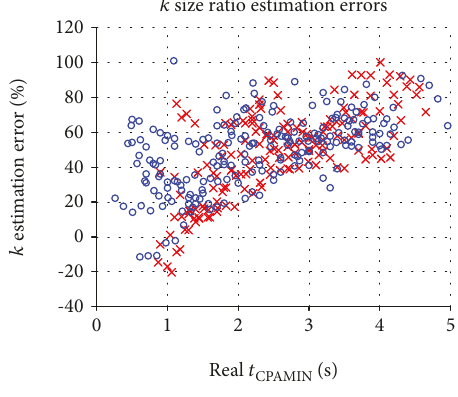
Figure 18: Estimation errors of size ratio (red x: close encounters; blue circle: far encounters).